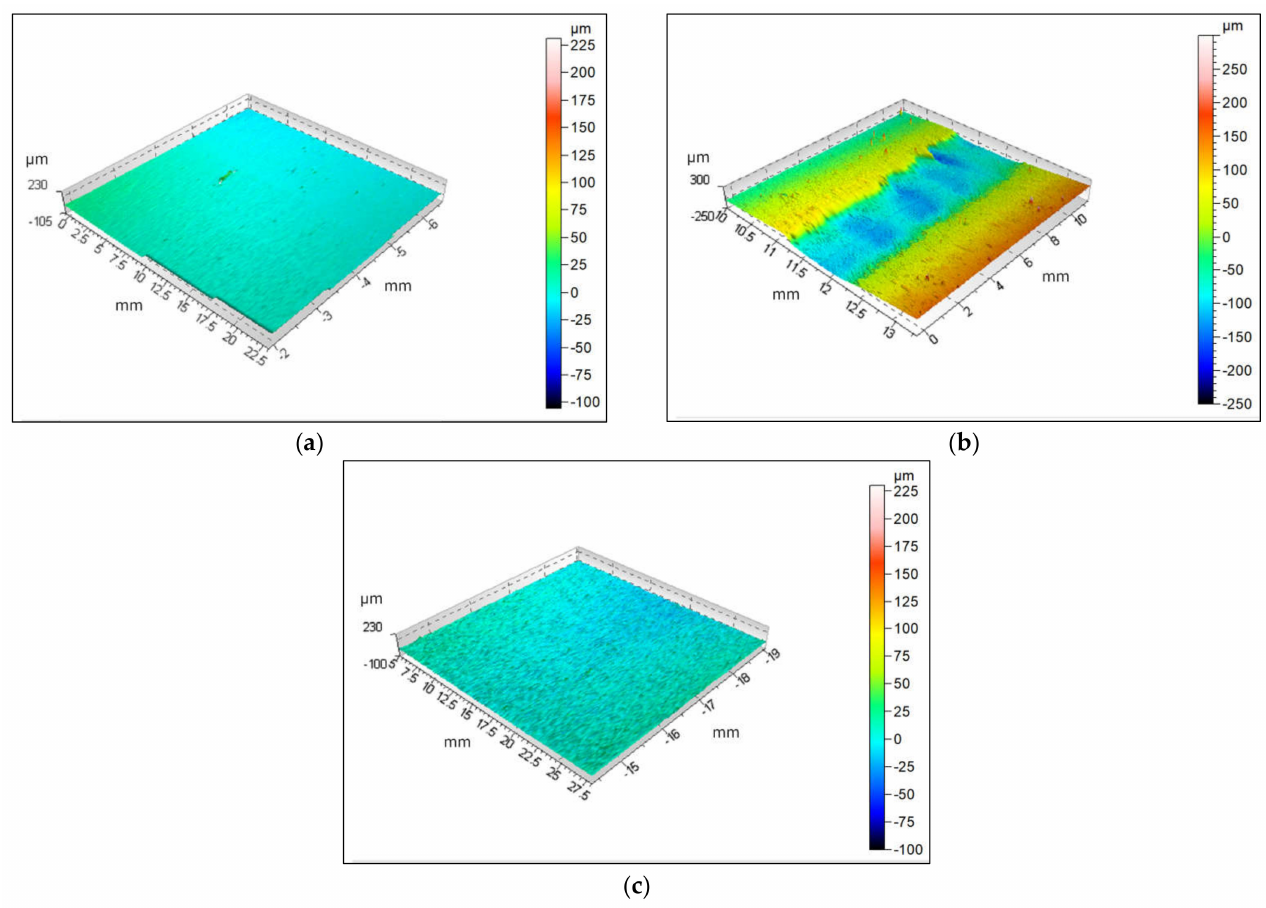
Figure 12. The 3D map: ( a ) base material CR180IF, ( b ) welded joint, ( c ) base material